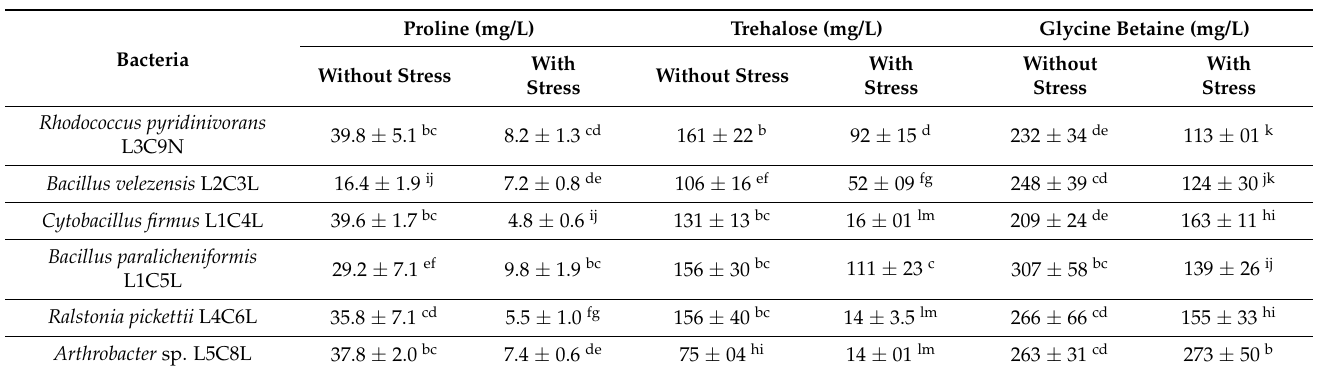
Table 2. Osmolyte production activities of screened EPS-producing sodic-tolerant bacteria isolated from sodic